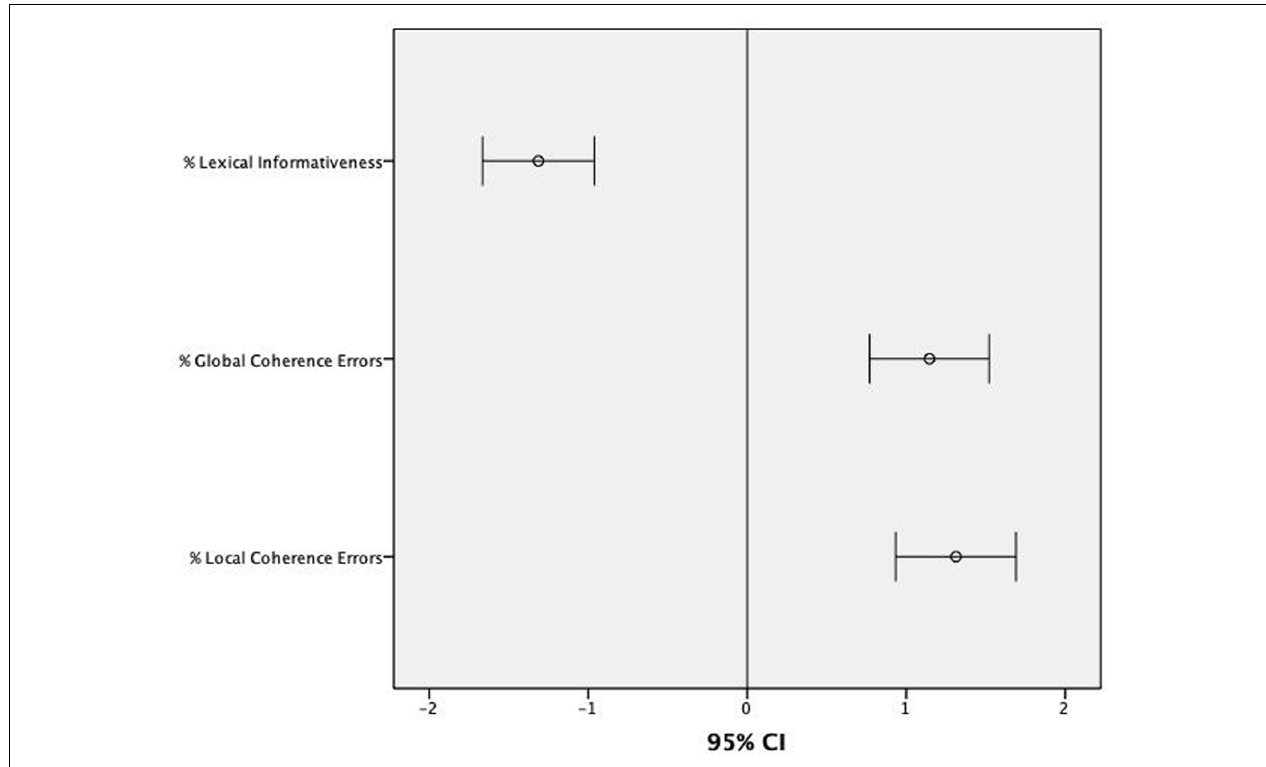
FIGURE 3 | Mean z-scores and 95% CIs for the scores assessing narrative skills in children with ASD in relation to normative data.